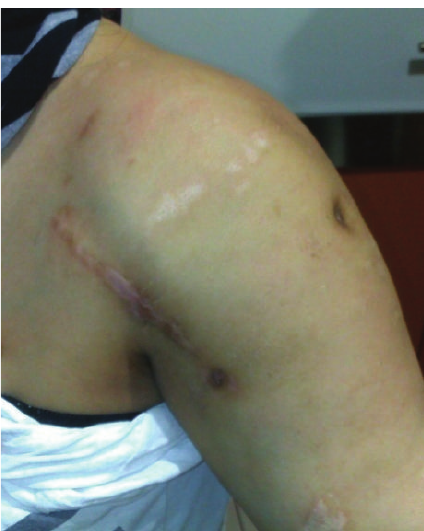
Figure 1: Clinical photograph of a 44-year-old female patient. The deltopectoral scar incision, which was performed surgically due to misdiagnosis of soft tissue tumor, can be seen.